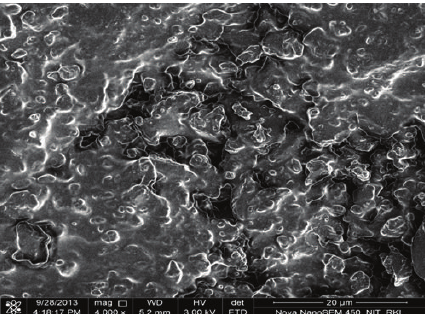
Figure 12: SEM of eroded composite surface (impact velocity 48 m/s, 10wt% filler, and impact 45 ∘ angle).